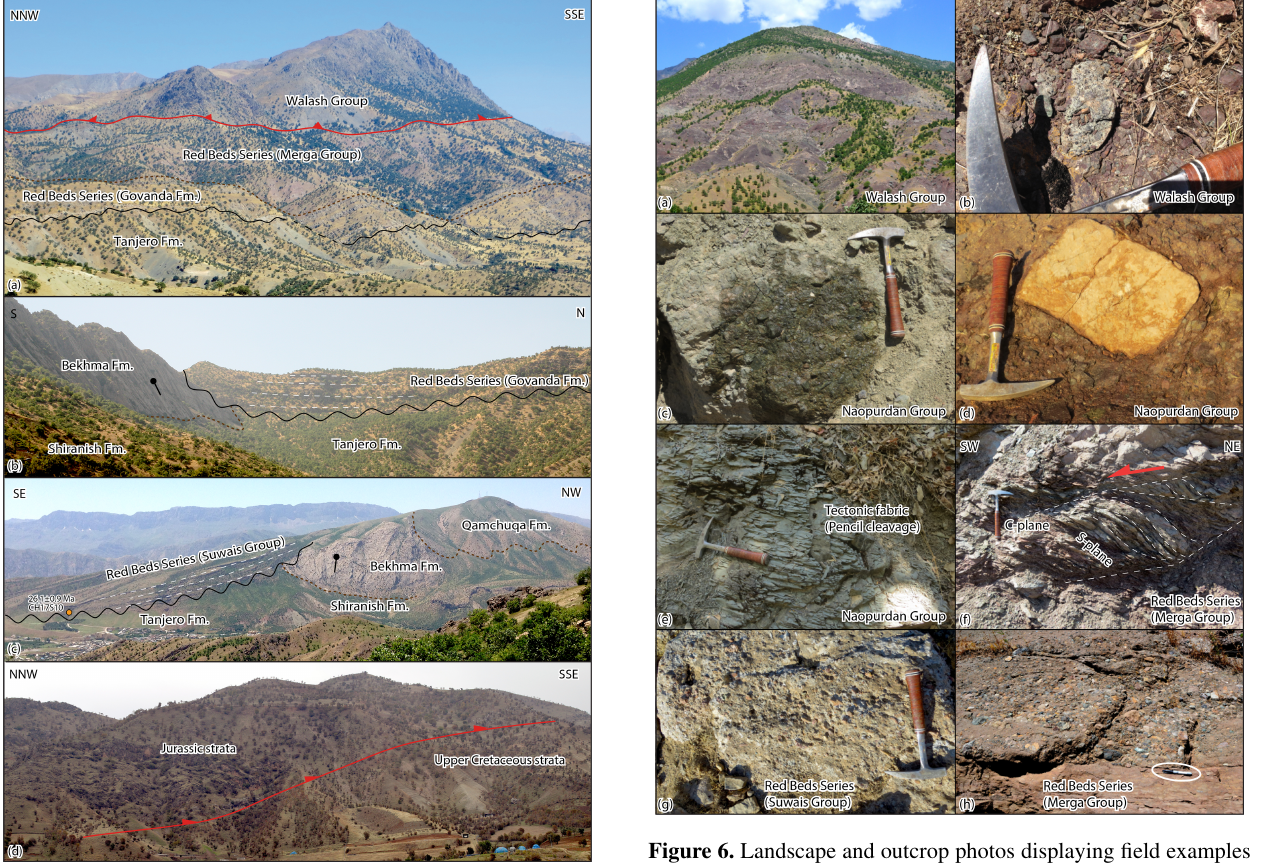
Figure 6. Landscape and outcrop photos displaying field examples of (a, b) the Walash Group, (c, d, e) the Naopurdan Group, and the Red Beds Series units of (f, h) the Merga Group and (g) the Suwais Group. The pencil cleavage tectonic fabric (e) developed in the lower part of the Naopurdan Group that thrusted onto the Merga Group. The C–S fabric developed in the upper part of the Merga Group that was overlain by the thrusted Walash